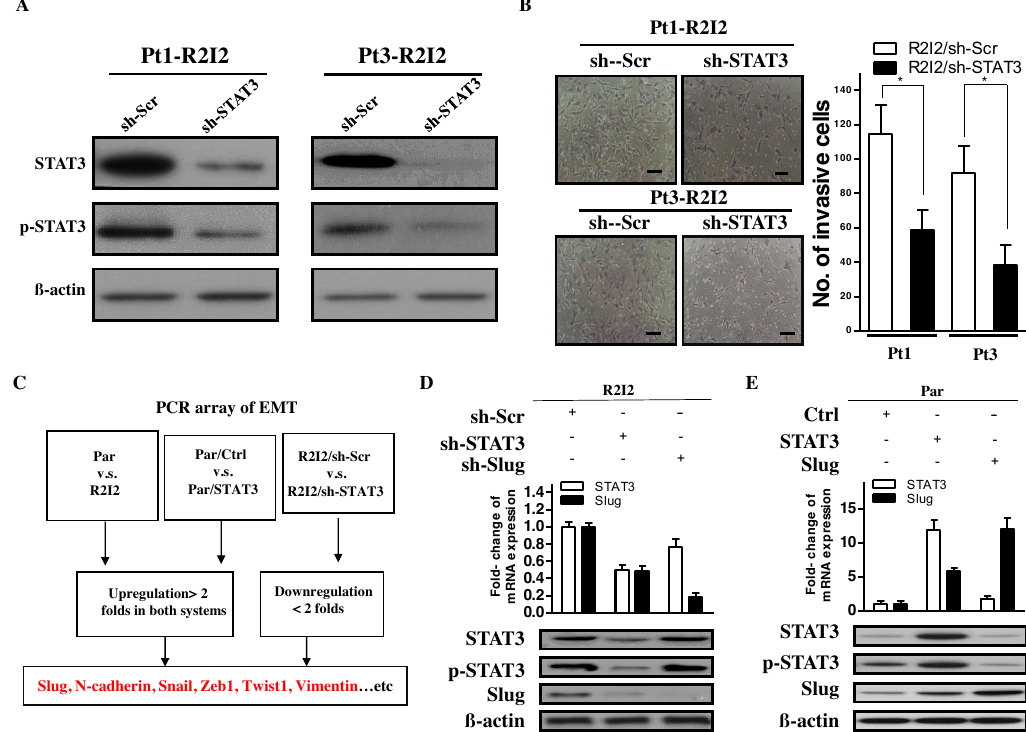
Figure 2. Slug is the downstream target of STAT3-modulated cell invasion. ( A ) STAT3-knockdown cell lines were generated in previously isolated Pt1-R2I2 and Pt3-R2I2 cells. Western blotting was used